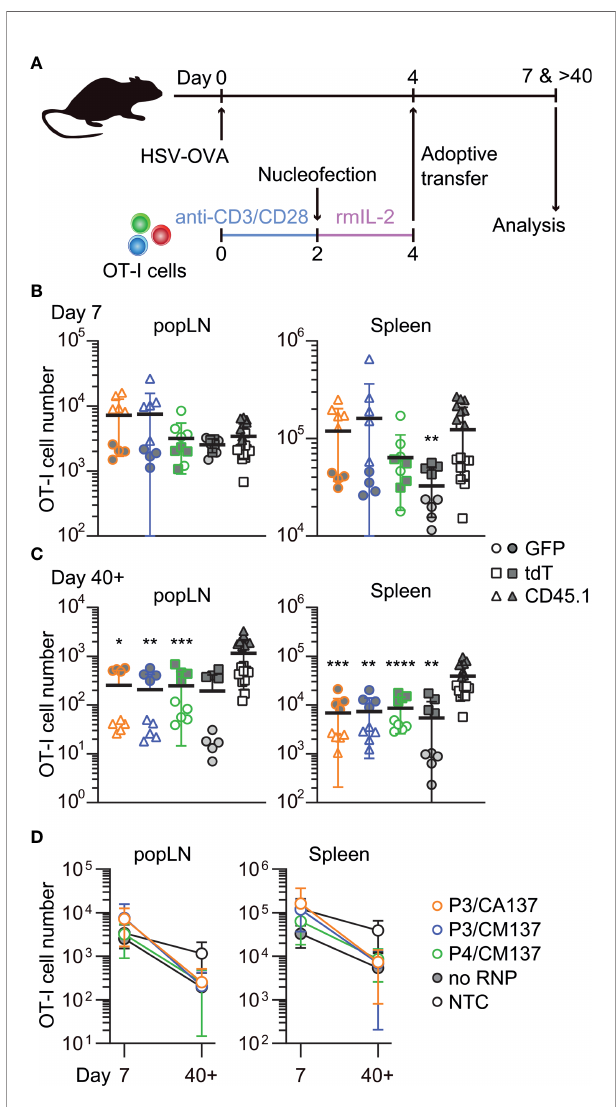
FIGURE 2 | In vivo survival/expansion of nucleofected in vitro -activated CD8 + T cells. (A) Experimental scheme. OT-I cells were nucleofected with three CD90 crRNAs using P3/CA137, P3/CM137 or P4/CM137. After nucleofection and 2-day culture in the presence of rmIL-2, 150,000 OT-I cells per group were injected into hosts (450,000 cells in total) that were subcutaneously infected with HSV-OVA 4 days before adoptive transfer of OT-I cells. Each host received three groups including NTC control. (B, C) OT-I cell number in popLN and spleen on days 7 (B) and > 40 (C) after infection. (D) Data shown in B and C plotted in 2D to gauge the severity of contraction. Graphs show pooled data from two independent experiments with n = 8 – 9 or 14 – 15 each nucleofected groups or non-nucleofected control, respectively. Congenic marker assignment was swapped in each experiment. * p < 0.05, ** p < 0.01, *** p < 0.001, **** p < 0.0001 as compared to NTC by Kruskal-Wallis test with Dunn ’ s multiple